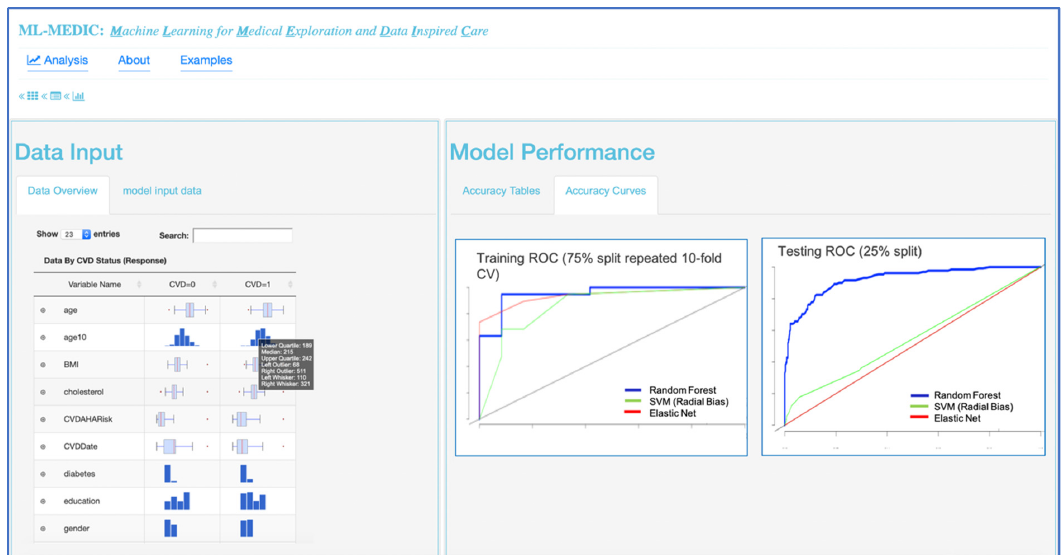
Figure 4. Results from case study 1 using ML ‐ MEDIC. Three machine learning models were conducted to assess their potential to predict cardiovascular disease (CVD) using factors in the American Heart Association (AHA)/American College of Cardiology (ACC) CVD risk score. For comparison, random forest (RF), support vector machine (SVM), and elastic net plots are shown. Data tables showing distributions split by the outcome CVD (response variable) are on the left. ROC curve of training data (75% 10 ‐ fold repeated CV) compared to ROC curve of testing data on the left.